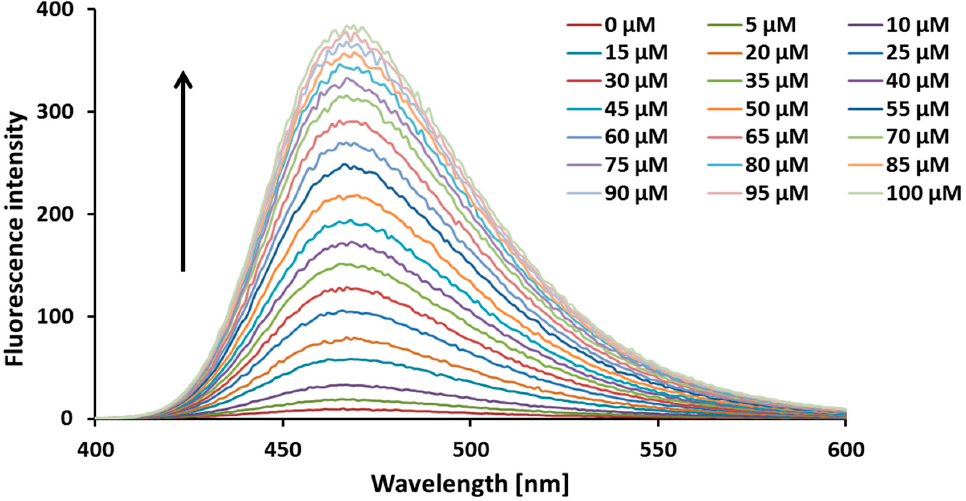
Figure 2. The increase in the fluorescence intensity of 6,7-dihydroxycoumarin (10 µM) with the addition of 4-amino-TEMPO (0–100 µM) in water at 25 °C.